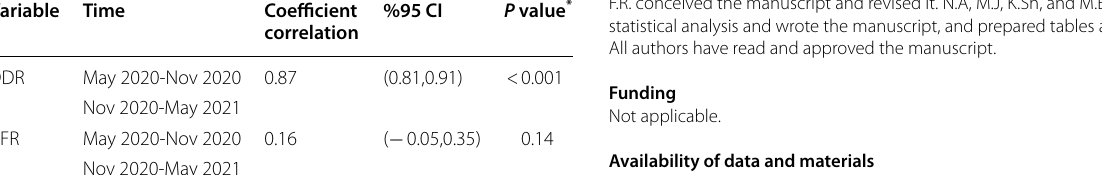
Table 5 Coefficient correlation between DDR/CFR at May 2020- Variable Time Coefficient %95 correlation